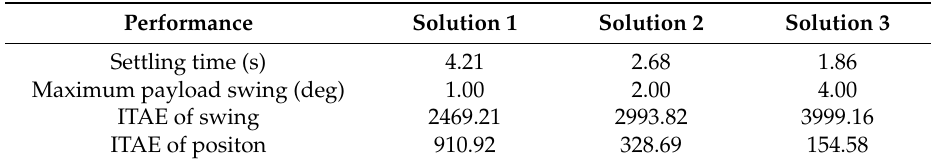
Table 3. Performance of three solutions. ITAE: integration of the time-weighted absolute value of the errors.